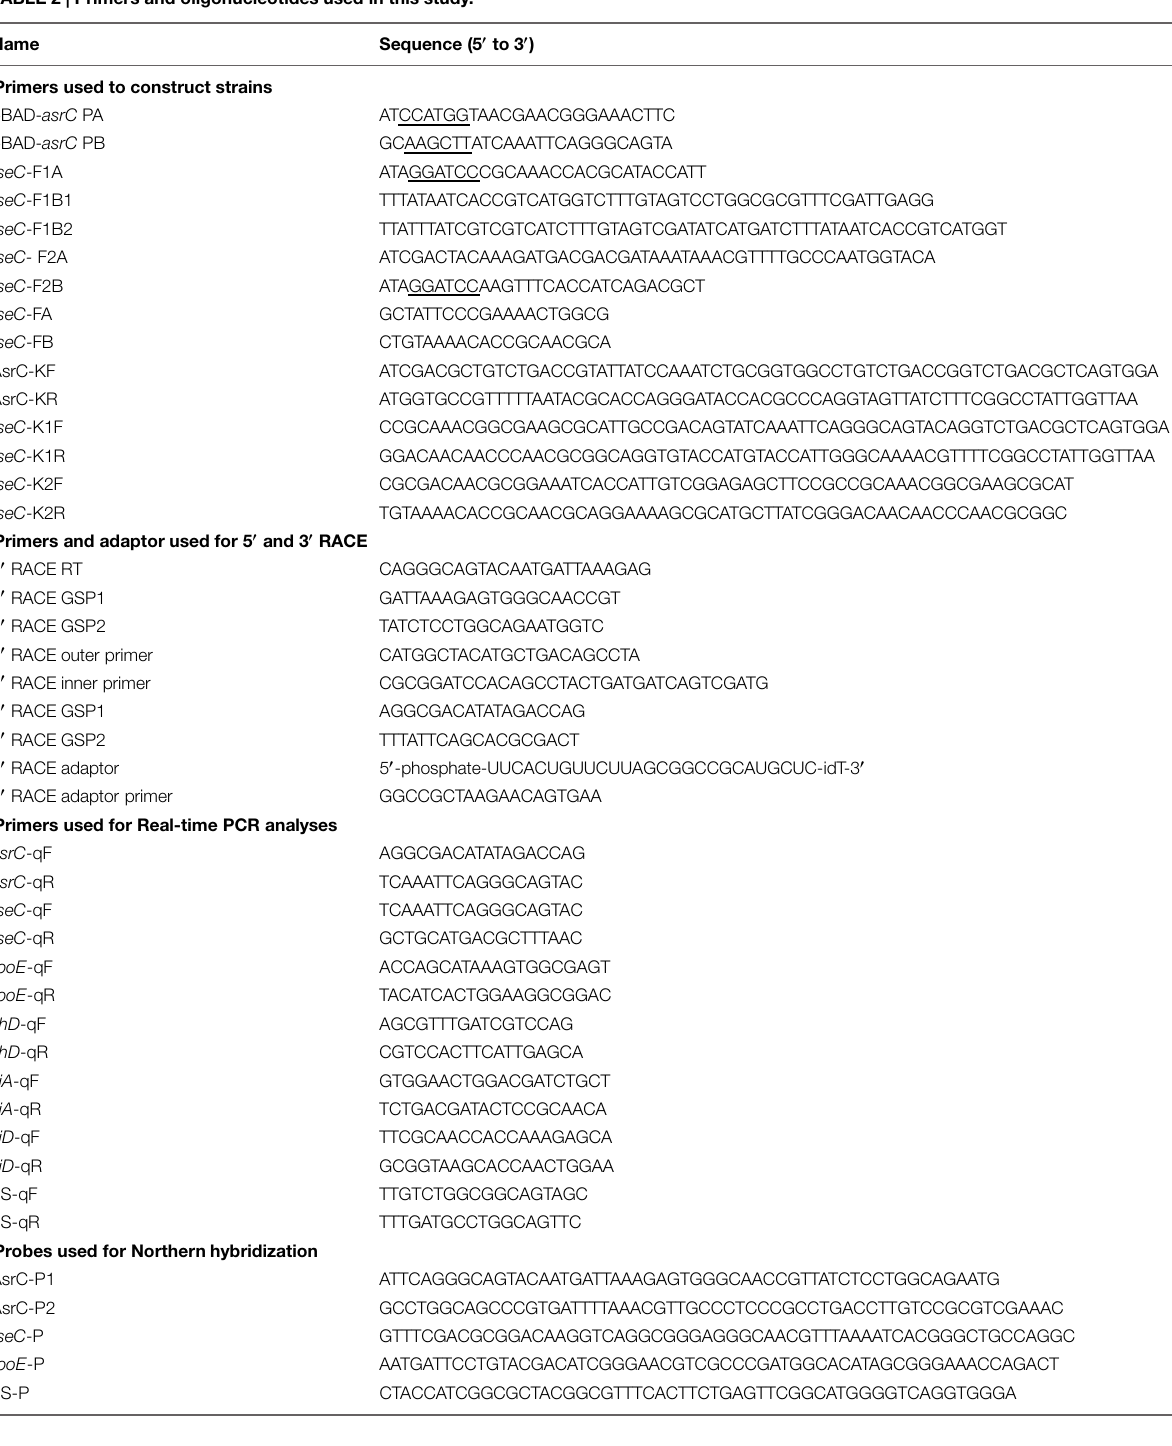
TABLE 2 | Primers and oligonucleotides used in this